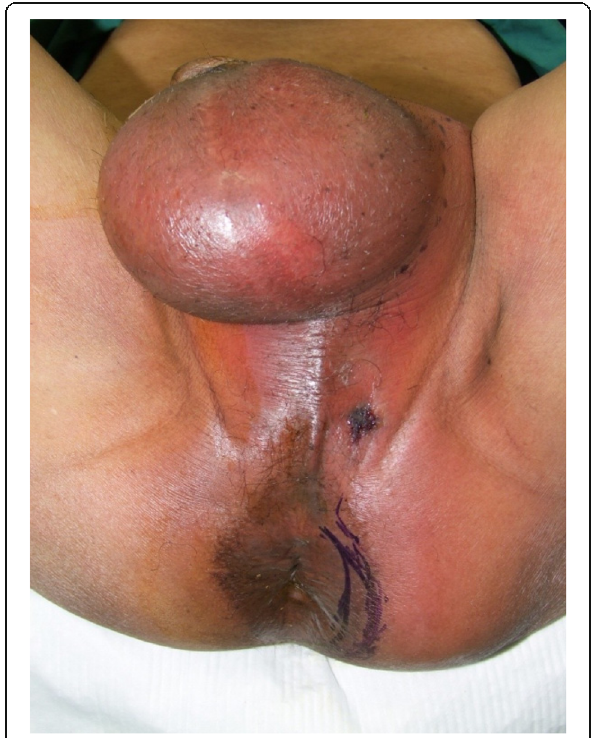
Fig. 3 The perineum and scrotum was swollen